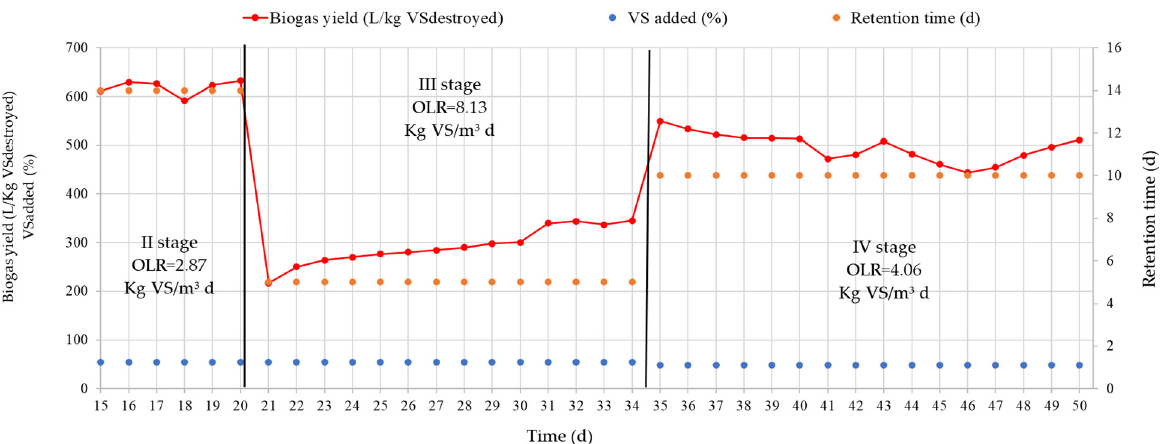
Figure 3. Biogas yield from the supplied amount of substrate VS destroyed and retention time at different